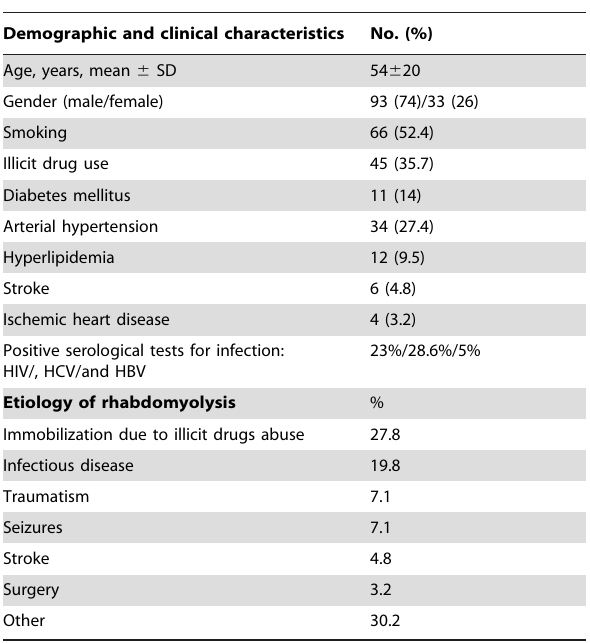
Table 1 . Characteristics of 126 patients with severe rhabdomyolysis a .